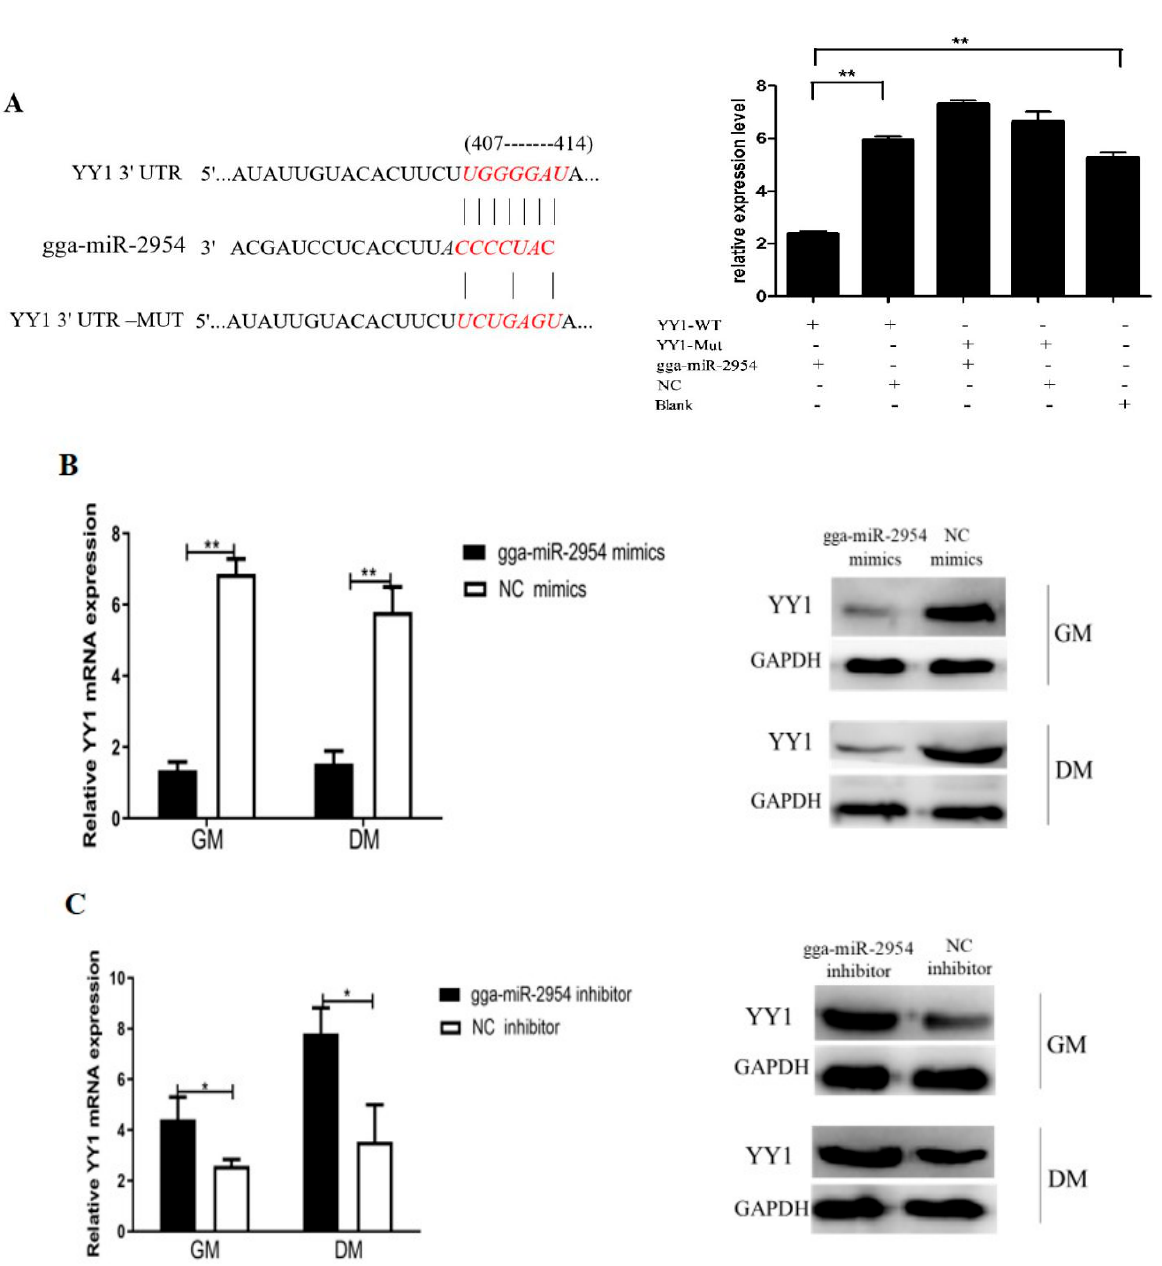
Figure 5. Gga-miR-2954 targets YY1 during myoblast myogenesis. ( A ) Luciferease reporter constructs based on the potential binding site of gga-miR-2954 with the 3’ UTR of YY1 and the detection of the relative luciferase activities in DF-1 cells. WT, wild-type. Mut, mutant-type. ( B ) The mRNA and protein expression of YY1 after transfection with gga-miR-2954 mimics. ( C ) The mRNA and protein expression of YY1 after transfection with gga-miR-2954 inhibitor. All measurements shown are the means ± SEM from at least three independent experiments (* P < 0.05; ** P < 0.01).